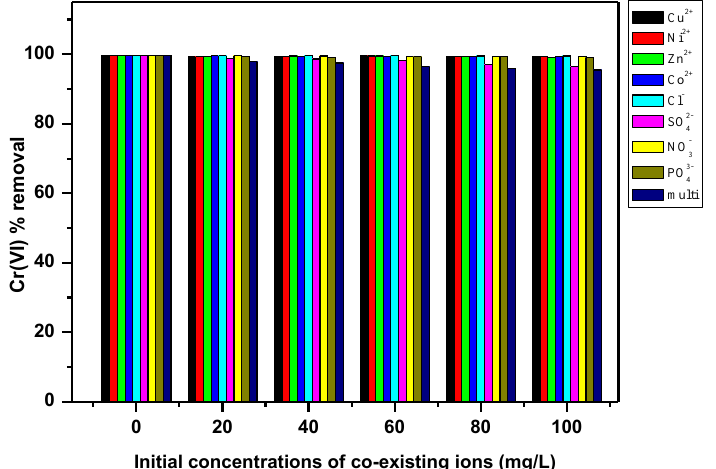
Figure 9. Effect of coexisting ions on Cr(VI) adsorption by the PPy– m PD/Fe 3 O 4 nanocomposite. Figure 9. E ff ect of coexisting ions on Cr(VI) adsorption by the PPy– m PD / Fe 3 O 4